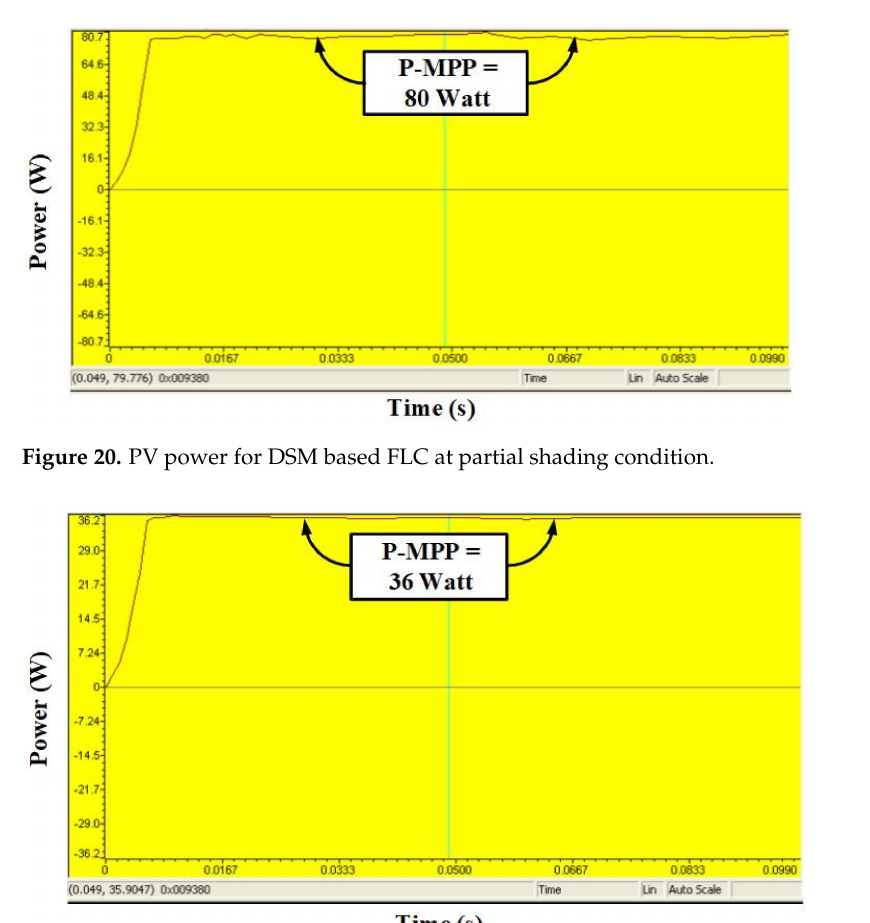
Figure 19. PV curve at normal and partial shading conditions.